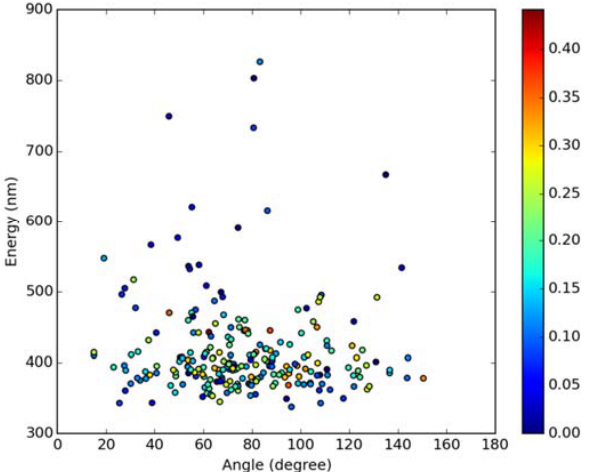
Figure 9. Emission energy vs fluorophore depth in DOPC bilayer Oscillatory strength is color ‐ coded.